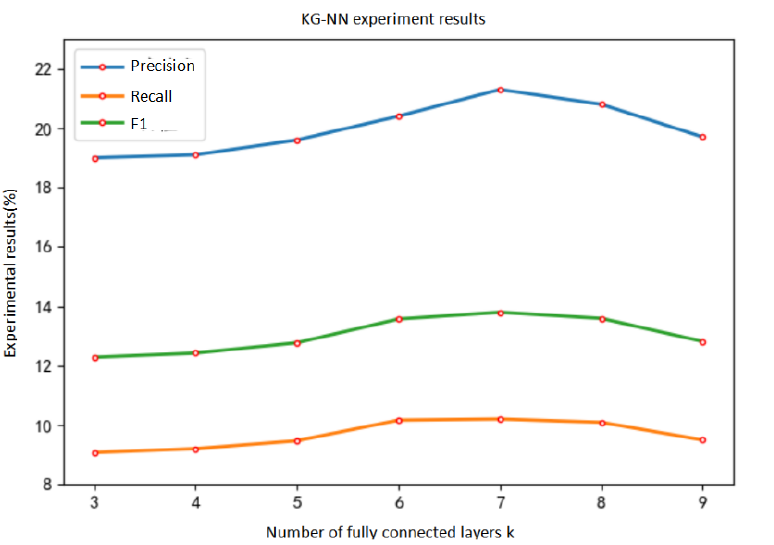
Figure 16. The effect of the number of fully connected layers on the experimental